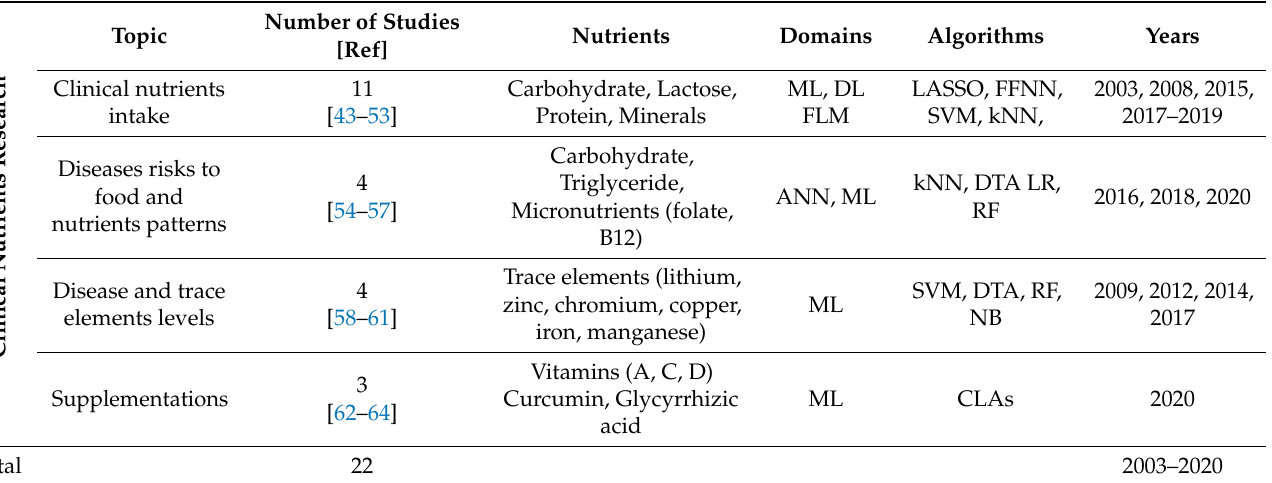
Table 2. The characteristics of the included studies on clinical nutrients